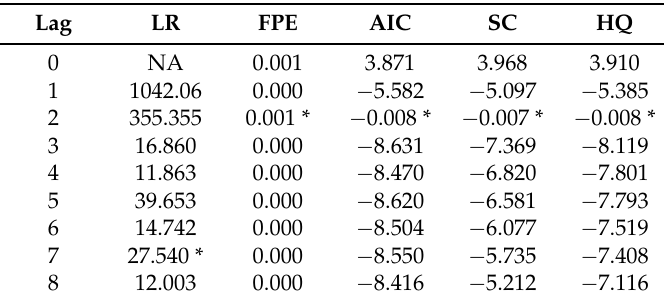
Table 3. Lag order selection